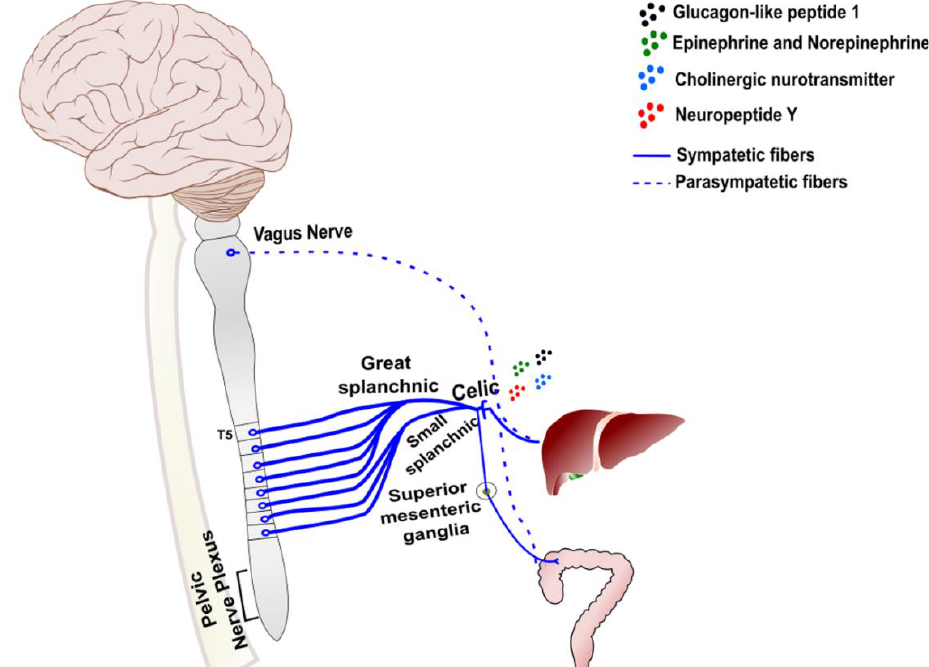
Figure 3. Arrangement of autonomic fibers in the liver. The interaction of the liver with the nervous system takes place through communication between the peripheral nerves and the vagus nerve, which largely innervates the peritoneal cavity. Sympathetic fibers that innervate liver tissue originate from neurons in the celiac and superior mesenteric ganglia. Furthermore, parasympathetic fibers originate mainly from preganglionic neurons located in the dorsal motor nucleus of the vagus nerve. Both are capable of interactions mediated by the release of adrenergic and cholinergic neurotransmitters and neuropeptides, such as neuropeptide Y, (continue on next page) leading to neuroendocrine-immune interactions that contribute to the modulation of inflammatory responses.